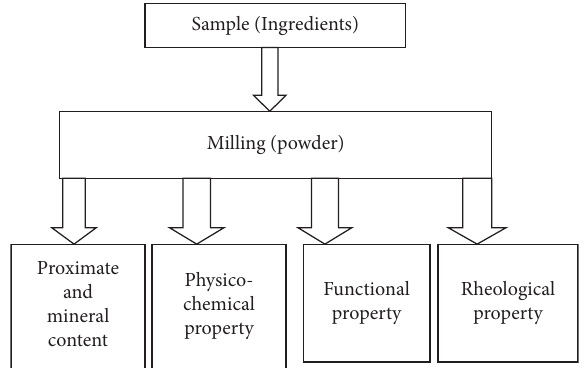
Figure 1: Work fowchart for the analysis of plant